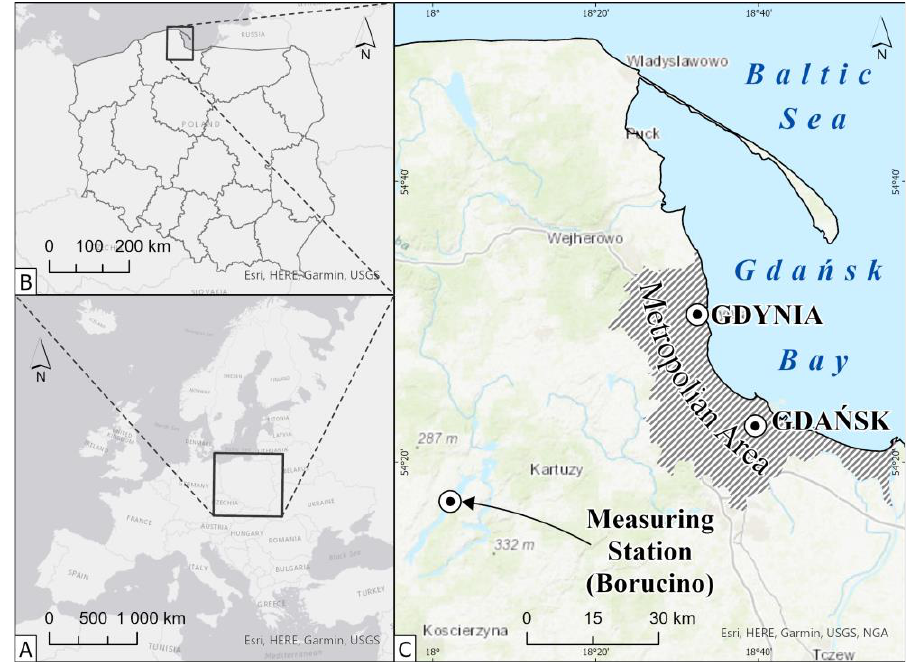
Figure 1. Location map of the study area in the context of ( A ) — Europe, ( B ) — Polish voivodeships, ( C ) — Tri-City Metropolitan Area.